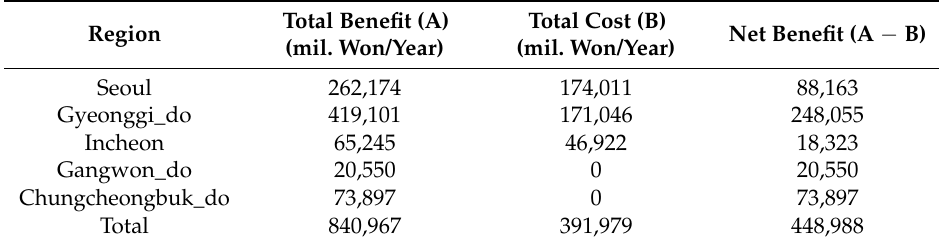
Table 7. Comparison of benefits and costs from the use of the Han River by each region based on RP